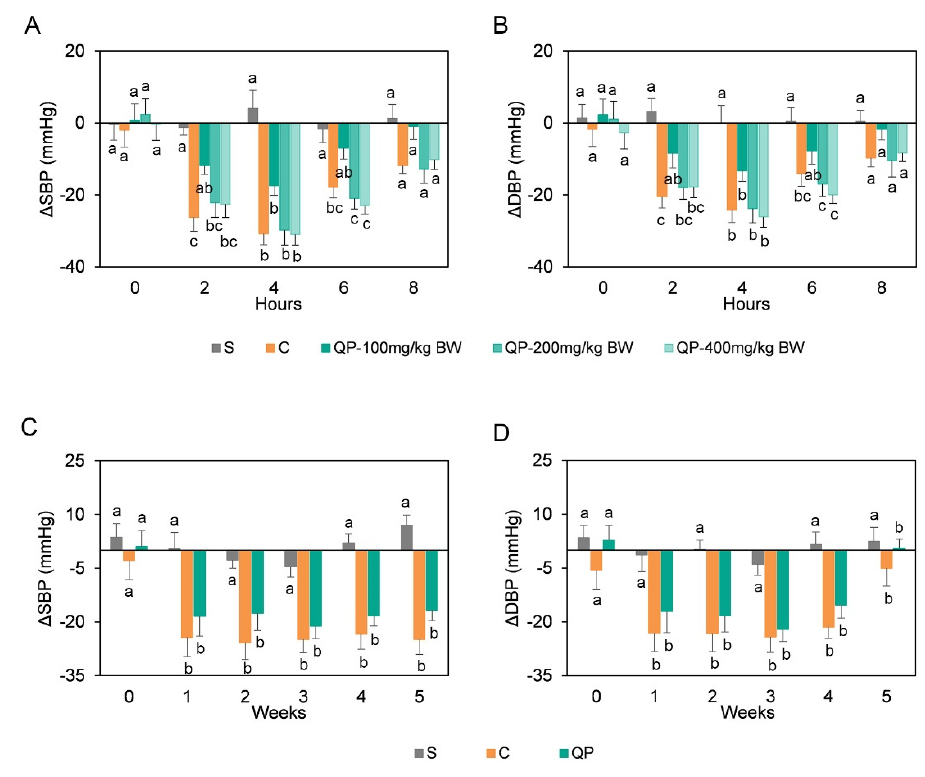
Figure 1. Oral administration of quinoa protein has an impact on the blood pressure of spontaneously hypertensive rats (SHRs). In the short-term study, systolic blood pressure (SBP) ( A ) and diastolic blood pressure (DBP) ( B ) in SHRs were measured at 0, 2, 4, 6, and 8 h after oral administration of saline solution (S), captopril (C), 100 mg/kg BW, 200 mg/kg BW, and 400 mg/kg BW quinoa protein (QP). In the long-term study, SBP ( C ) and DBP ( D ) of SHRs were measured during five-week administration of saline solution (S), captopril (C), and 200 mg/kg BW quinoa protein (QP). Based on the initial blood pressure value before intervention, change values of blood pressure ( ∆ SBP and ∆ DBP) were expressed as the mean ± standard error of the mean. At each time point, columns with different letters are significantly different at p < 0.05.